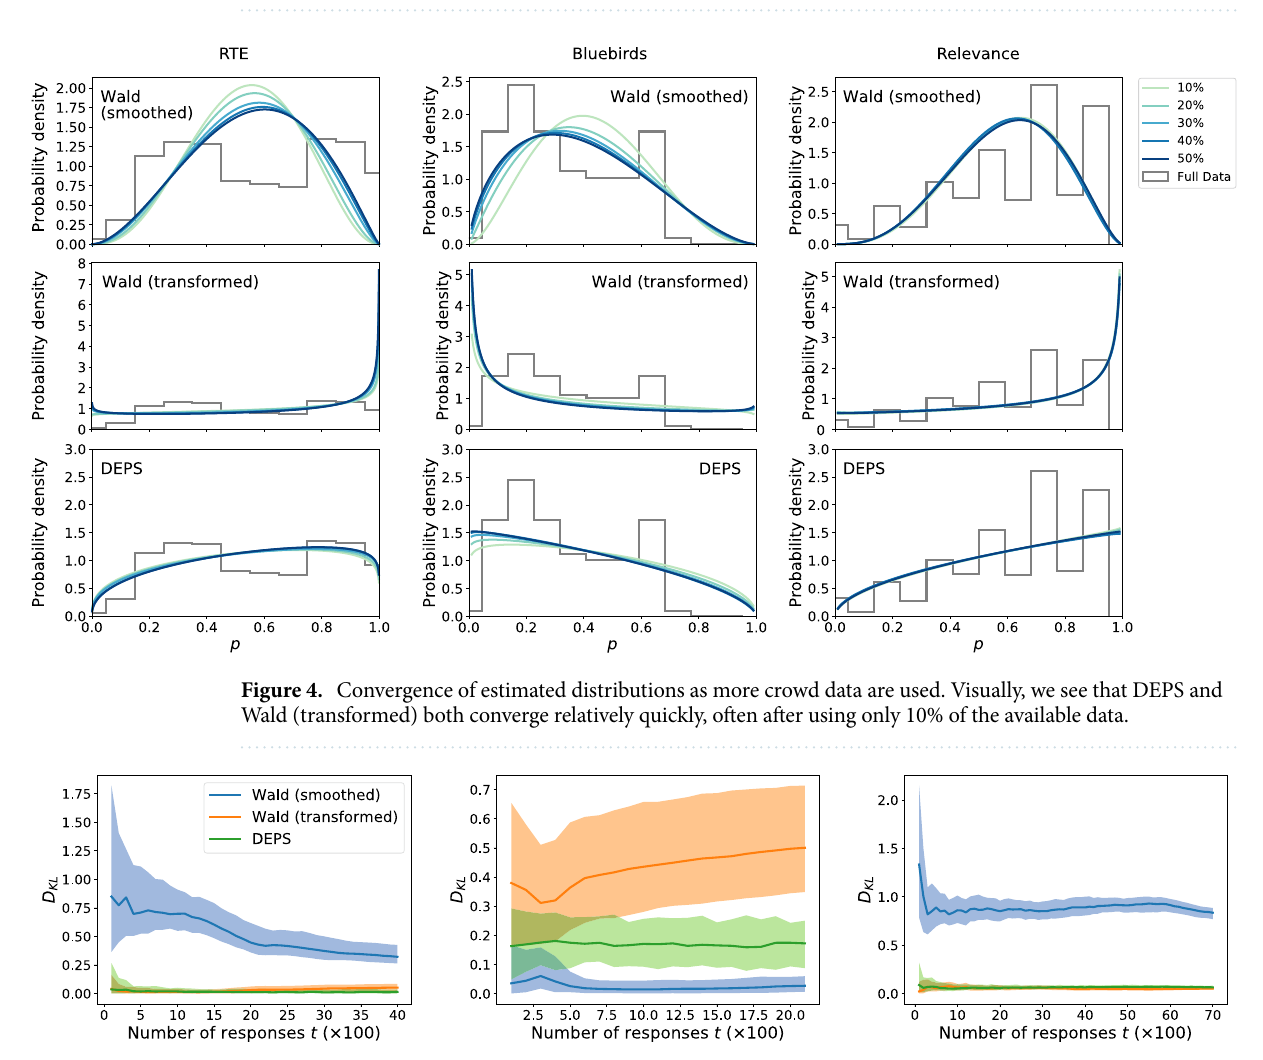
Figure 3. Inference of problem difficulty distributions using 25% of labels. Tasks are allocated using Requallo, then Wald estimation or DEPS estimation of problem difficulty is performed. These results are compared to the distribution of ˆ p estimated using the full dataset (100% of labels), show as histograms. The “smoothed” and “transformed” variants of Wald estimation tend to add too much probability near either the center ( p = 1 / 2 ) or extremes ( p = 0, 1 ). DEPS achieves good agreement with the full data distribution.